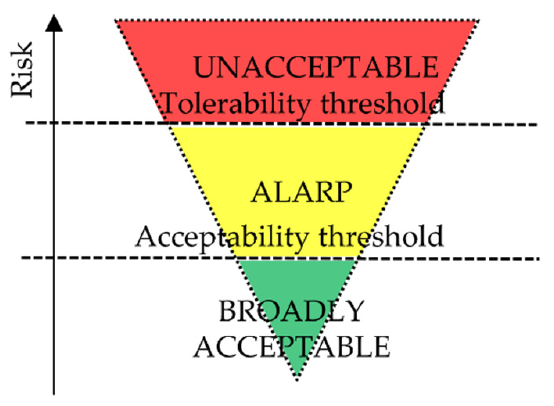
Figure 2. The ALARP principle.